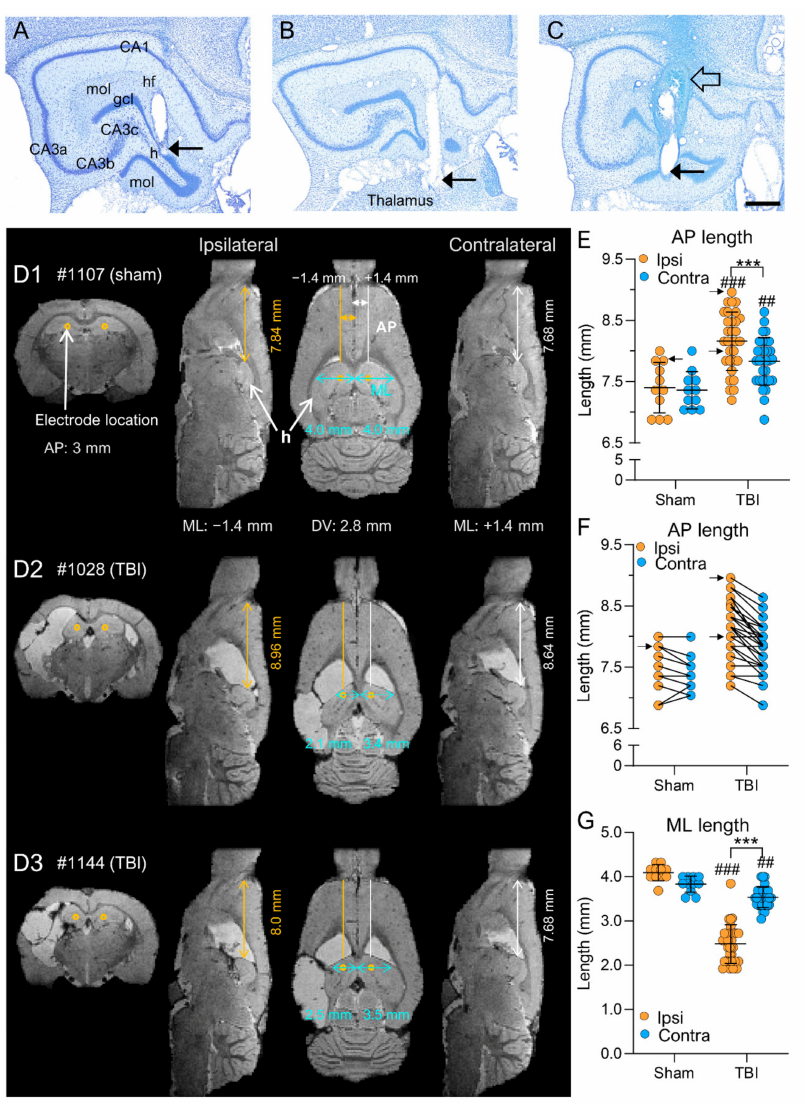
Figure 9. ( A – C ) Electrode tracts. Histological images from the coronal thionine-stained sections of 3